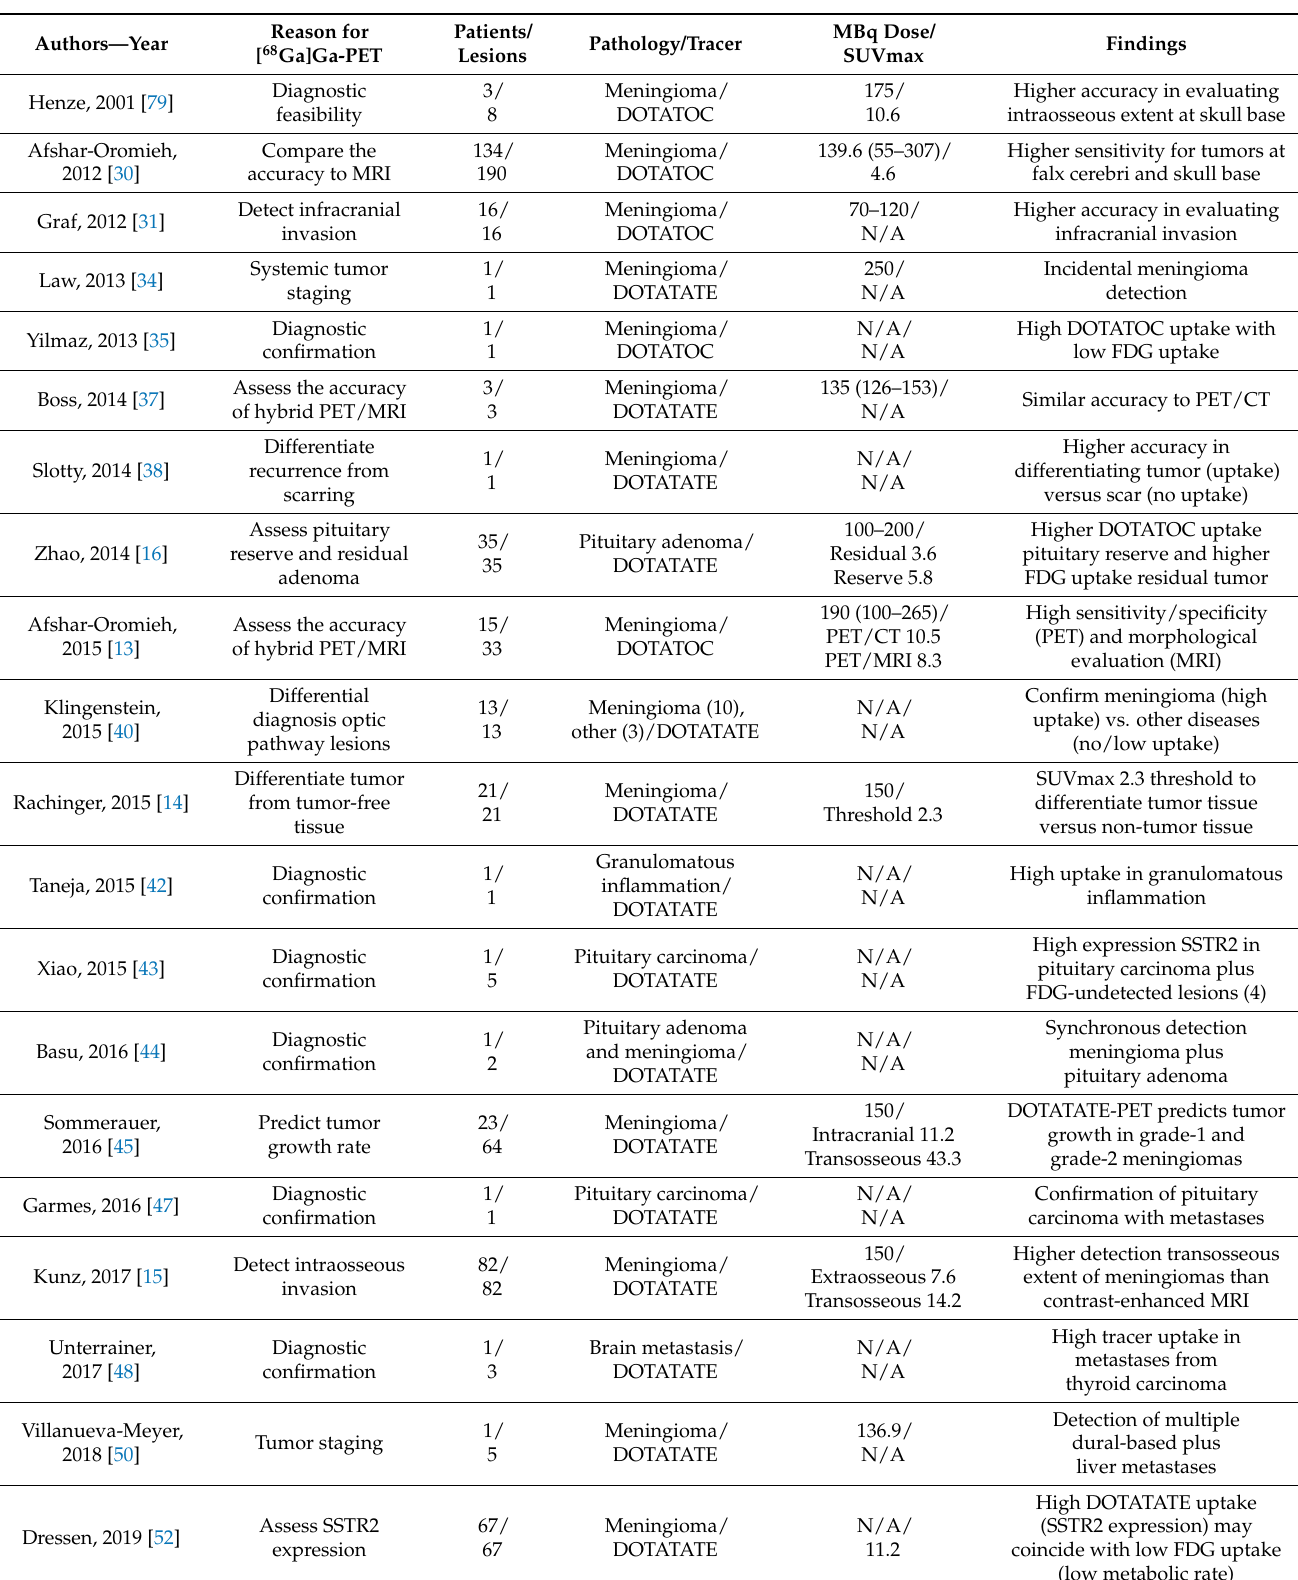
Table 2. Overview of all included studies using [ 68 Ga]Ga-DOTA-SSTR PET for diagnostic